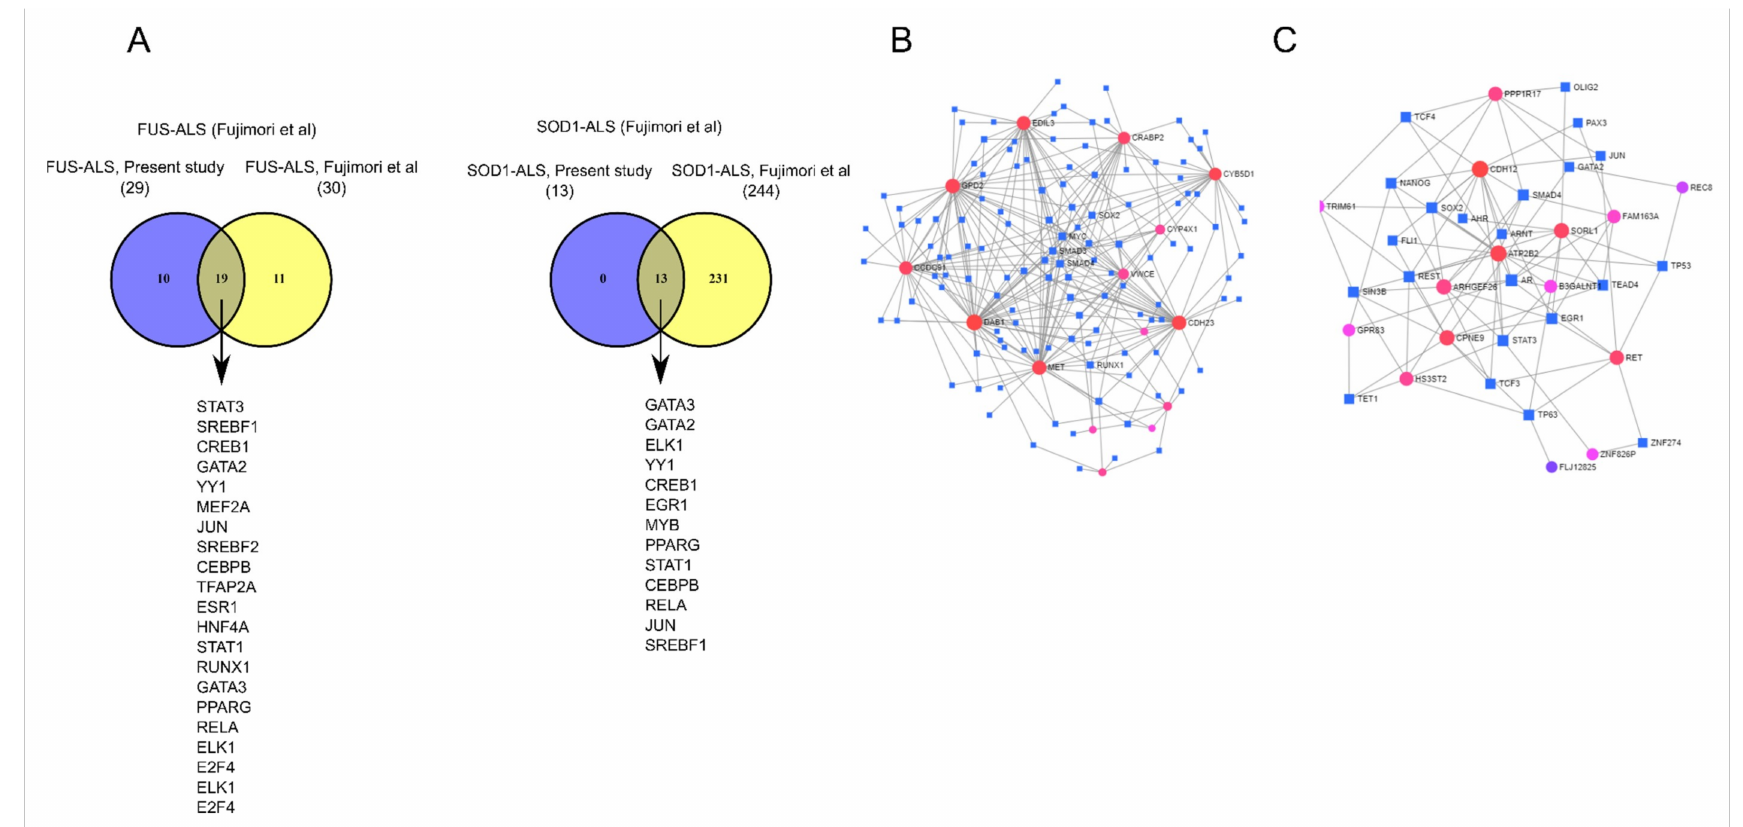
Figure 3. Transcription factor–DEG regulatory interaction network analysis. ( A ) Venn diagrams depicting the TFs specific or common among FUS-ALS and SOD1-ALS datasets. ( B ) Construction of DEG–TF interaction networks based on DEGs identified shared by FUS-ALS datasets (present study vs. GSE106382). ( C ) Construction of DEG–TF interaction networks based on SOD1-ALS datasets (present study vs. GSE106382) and the minimum connected network was analyzed further. The DEG–TF interaction networks were analyzed in NetworkAnalyst tool [36] (i.e., degree of connectivity and betweenness centrality) and statistical significance score p < 0.05 was used for the construction of